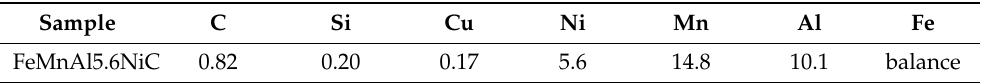
Table 1. The chemical composition of the samples is given in percent by weight.